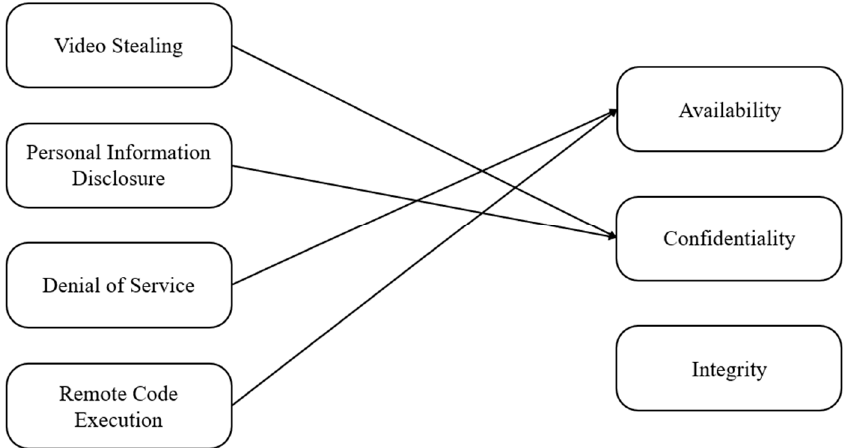
Figure 12. Security’s fundamental principles (CIA) that each attack violates.